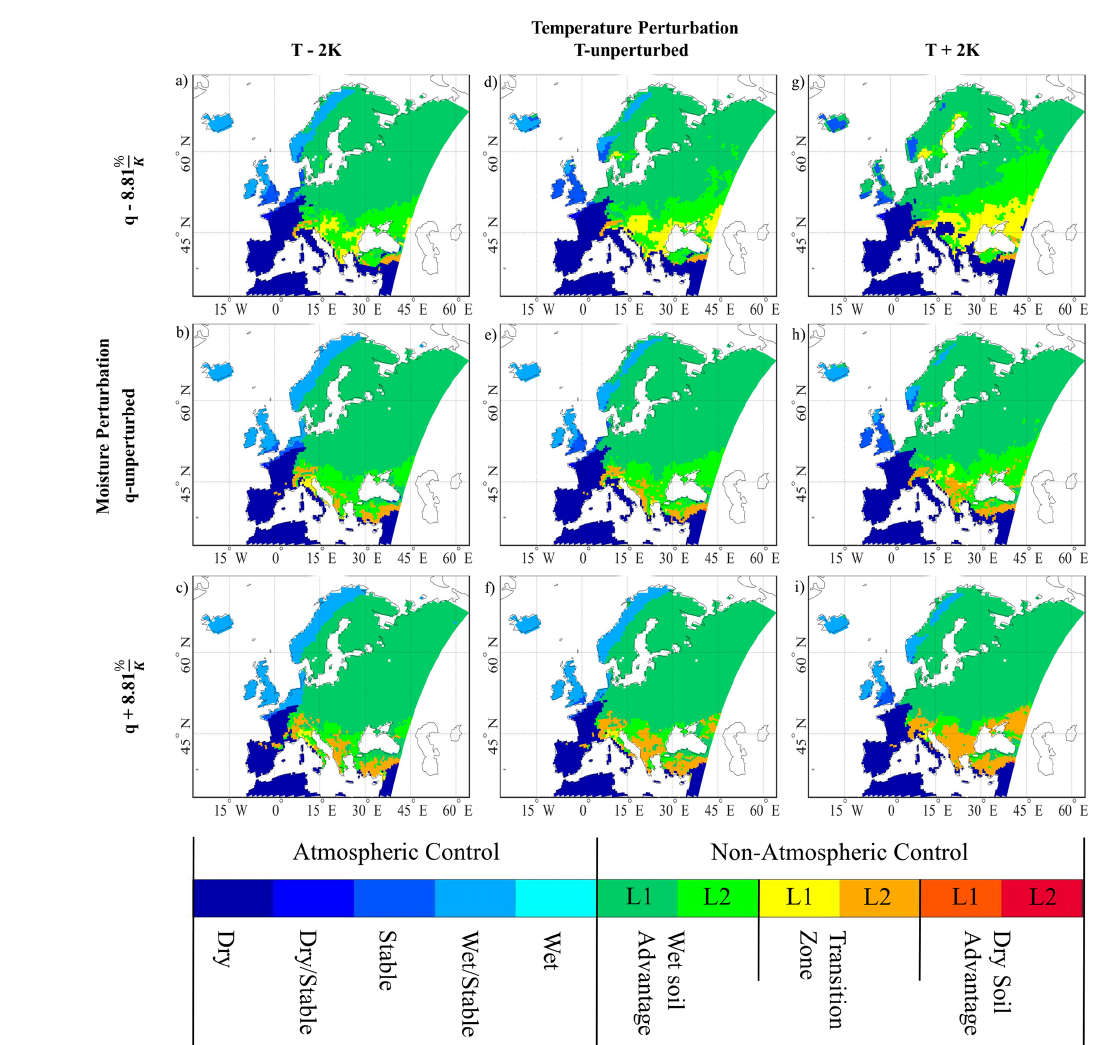
Figure 7. Long-term classification of coupling regimes for the core set modification cases. The columns denote a temperature change and the rows a change in moisture. The center image is the CTRL case and modified after Jach et al. (2020) (their Fig. 3a). The columns denote the temperature change and the rows the relative change in